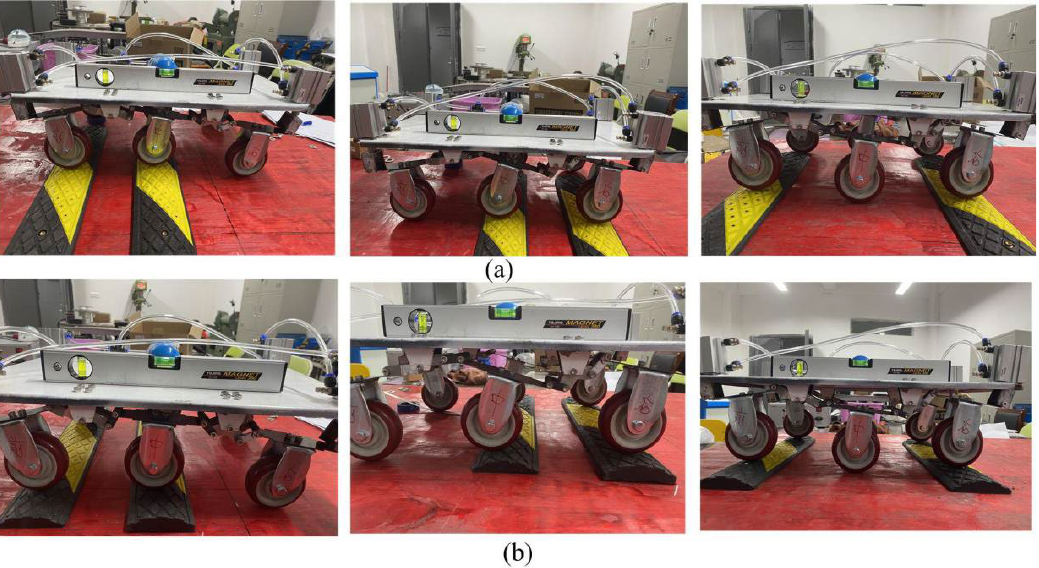
Figure 21. Two-wheel obstacle crossing test: ( a ) single side double wheel obstacle crossing test; ( b ) double side double wheel obstacle crossing test.